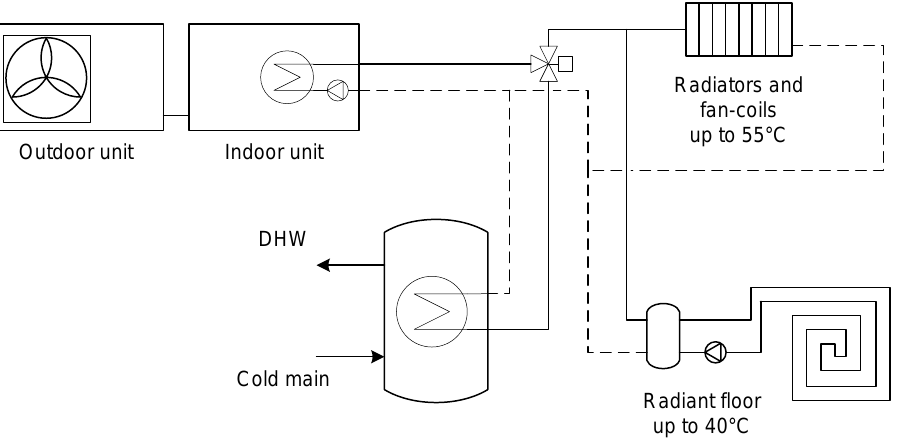
Figure 1. Domestic aerothermal heat pump system diagram.